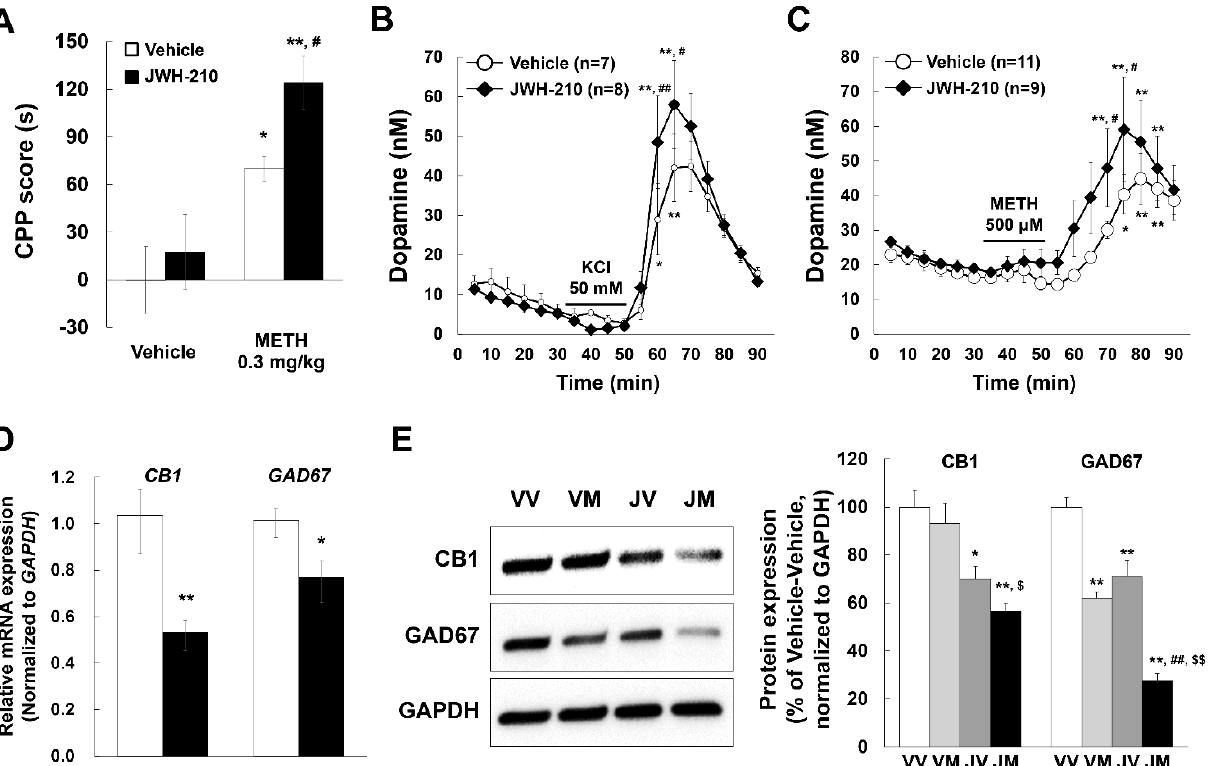
Figure 3. Effects of JWH-210 on METH-induced CPP, KCl-induced dopamine release, or METH-induced dopamine efflux and CB1 and GAD67 expression in mice striatum. Before starting the CPP test, acute brain slices, and dissecting the brain, mice were injected with either a vehicle or JWH-210 (0.1 mg/kg, i.p.) once every day for 5 days. ( A ) 0.3 mg/kg METH-induced CPP scores (s) was measured by CPP test. Data are expressed as the mean ± S.E. ( n = 13) and were analyzed using two-way ANOVA followed by Bonferroni post-hoc t -test (* p < 0.05 and ** p < 0.01 vs. each vehicle group; # p < 0.05 vs. vehicle/METH group). ( B ) 50 mM KCl-induced dopamine release or ( C ) 500 µ M METH-induced dopamine efflux in brain striatal slices were measured by using HPLC. Data are expressed as the mean ± S.E. ( n = number of mice) and were analyzed using two-way RM ANOVA followed by Bonferroni post-hoc t -test [* p < 0.05, ** p < 0.01, and ** p < 0.01 vs. each basal level (at 30 min); # p < 0.05 and ## p < 0.01 vs. vehicle group on the same time]. ( D ) Mice striatum were collected after 1 day following the final injection. mRNA levels of CB1 and GAD67 were detected by qPCR and normalized relative to the amplification of GAPDH in the mice striatum. Data are expressed as the mean ± S.E. ( n = 5–9, Student’s t -test; * p < 0.05 and ** p < 0.01 vs. vehicle group). ( E ) Mice striatum were collected after CPP test. The protein expression of CB1 and GAD67 was detected by Western blotting using specific antibodies and normalized to the relative amplification of GAPDH. Data are expressed as the mean total distance traveled ± S.E. ( n = 5) and were analyzed using one-way ANOVA followed by Holm–Sidak post-hoc t -test (* p < 0.05 and ** p < 0.01 vs. VV group; ## p < 0.01 vs. VM group; $ p < 0.05 vs. JV group, $$ p < 0.01 vs. JV group). METH: methamphetamine. VV: vehicle + vehicle group. VM: vehicle + methamphetamine